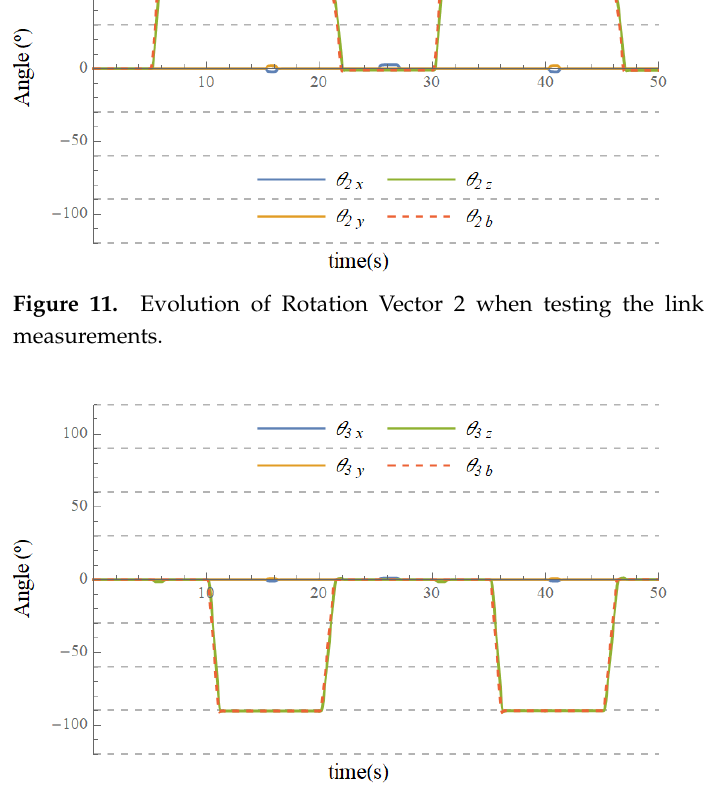
Figure 12. Evolution of Rotation Vector 3 when testing the link model using only encoder